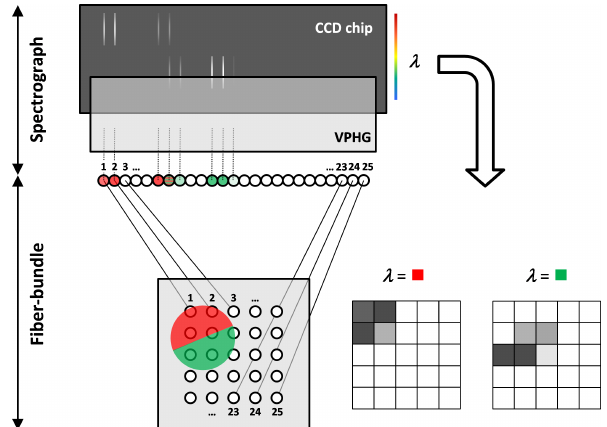
Figure 1. Function principle of fiber bundle-coupled IFS. The im- age of the sample (red and green semi-circles) is focused on the fiber matrix of the image acquisition head. At the spectrograph side, the fibers are arranged in a one-dimensional row. After passing a spec- tral disperser (e.g., a volume phase holographic grating, VPHG), ev- ery fiber produces an individual intensity- and spectrum-dependent light trace at the CCD chip. The raw signal of the CCD is evaluated by software and converted into a data cube that contains the entire spectral and spatial